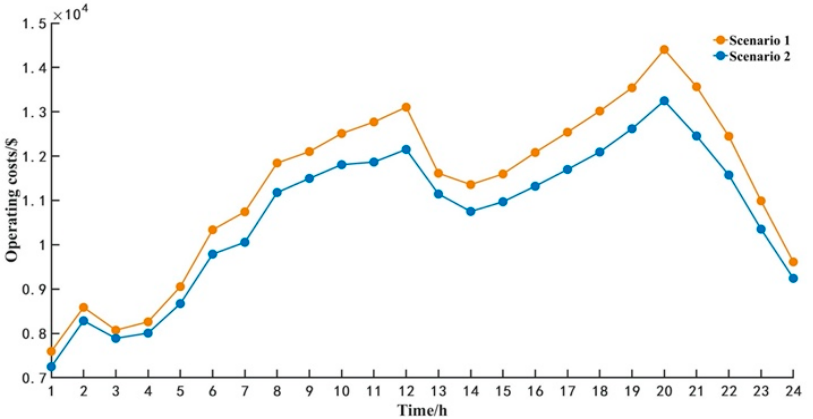
Figure 6. Hourly operation cost comparison.